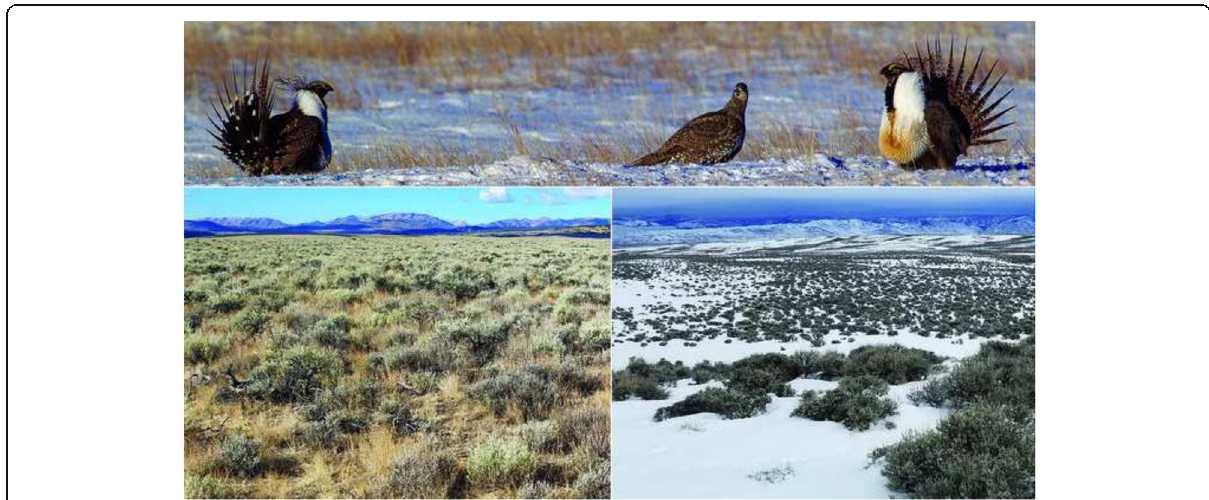
Fig. 1 Lekking greater sage-grouse (top panel) and sagebrush habitat in the summer (bottom left panel) and winter (bottom right panel) in Sublette County,